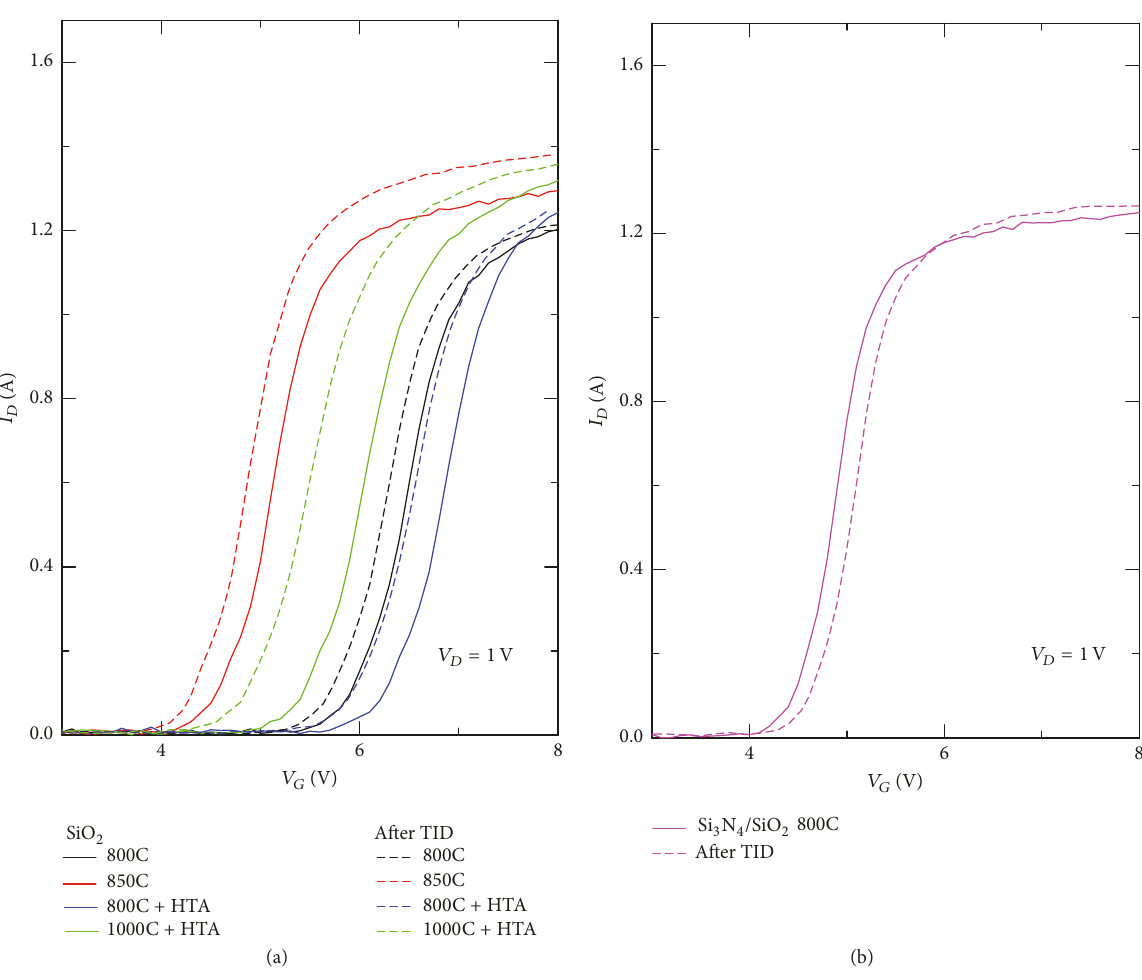
Figure 1: 𝐼 𝐷 - 𝑉 𝐺 characteristics of Si VDMOS with different gate dielectrics and different oxidation conditions before and after TID irradiation with 𝑉 𝐺 = 10V (solid: before TID; open: after